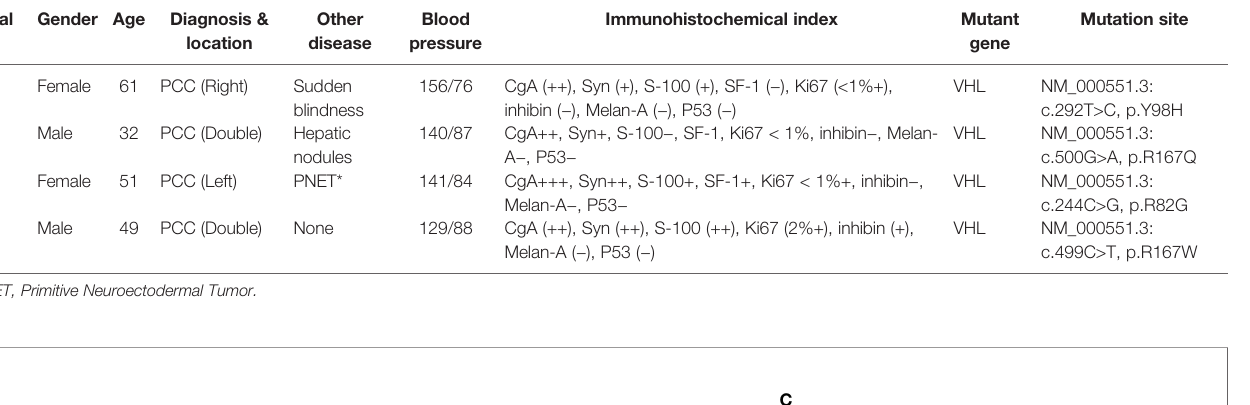
TABLE 1 | Characteristics and mutation sites of four patients with VHL-mutated pheochromocytomas. Serial No.